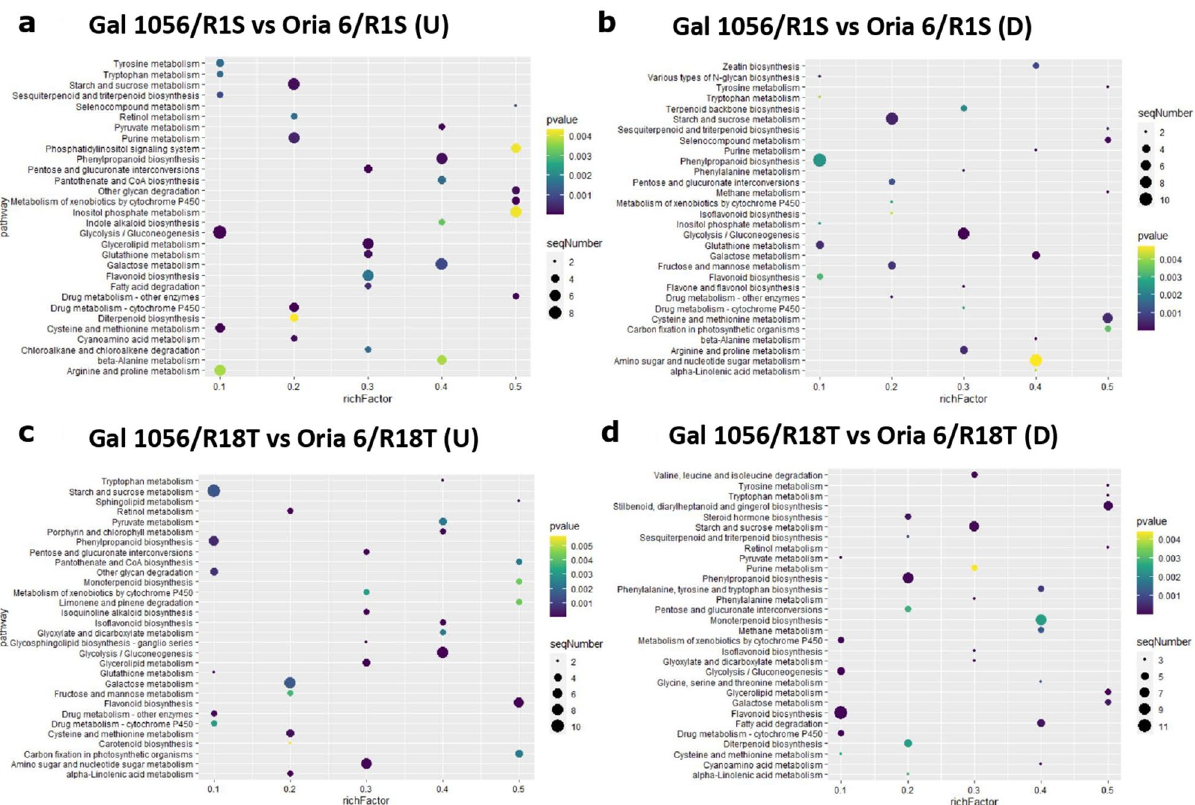
Figure 6. Top 30 enriched KEGG pathways analysis. ( a ) Significantly upregulated (≥ 1.5 Log2FC) and ( b ) downregulated (≤ − 1.5 Log2FC) genes exclusively differentially expressed in Gal 1056/R1S versus Oria 6/ R1S. ( c ) Significantly upregulated (≥ 1.5 Log2FC) and ( d ) downregulated (≤ − 1.5 Log2 FC) genes exclusively differentially expressed in Gal 1056/R18T versus Oria 6/R18T. Rich factor represents the ratio of the DEGs number and the number of all genes in the pathway. P values ( P < 0.05) were calculated according to the Wald test.